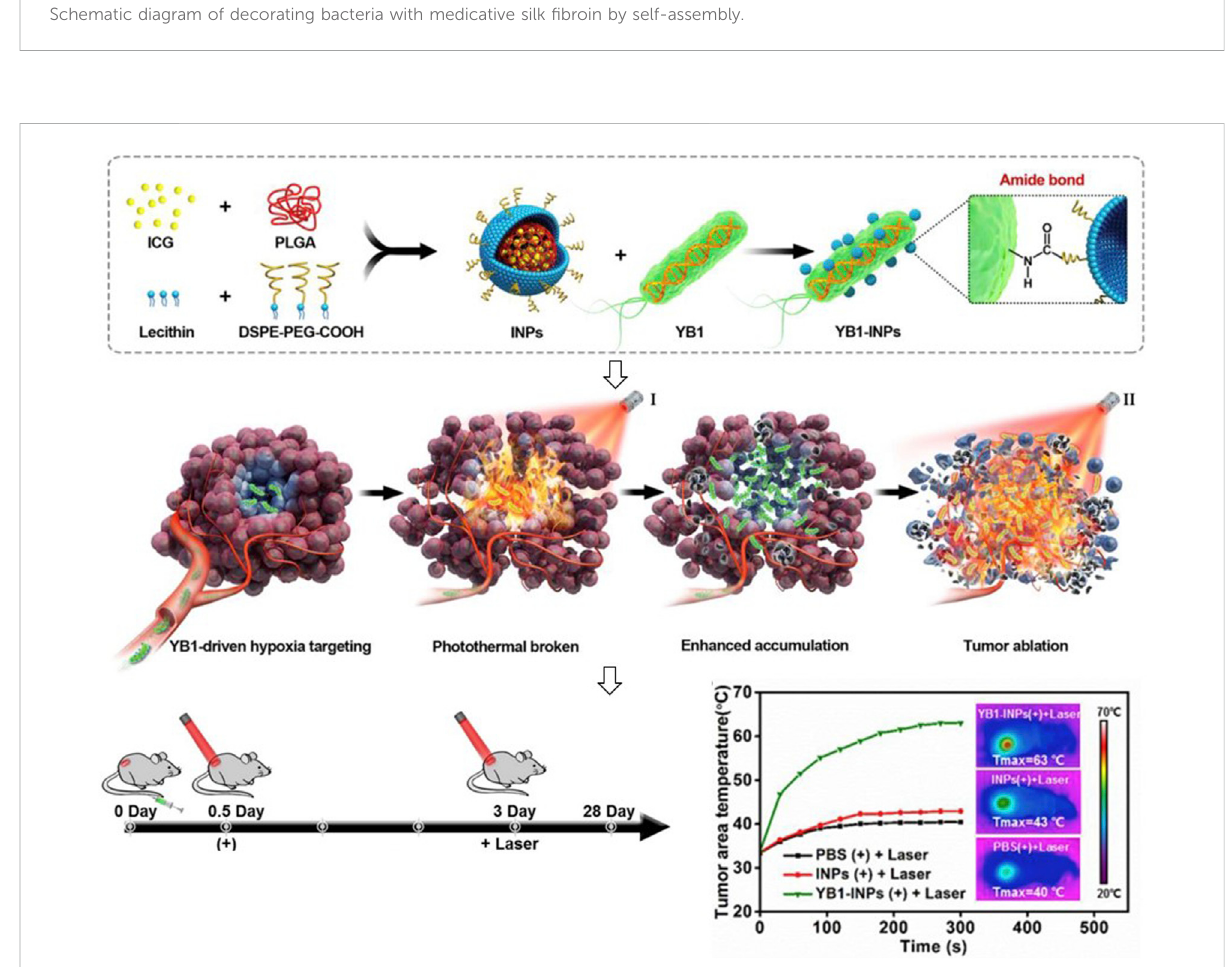
FIGURE 4 Encapsulation of indocyanine green-loaded nanoparticles on the surface of bacteria for tumor therapy.